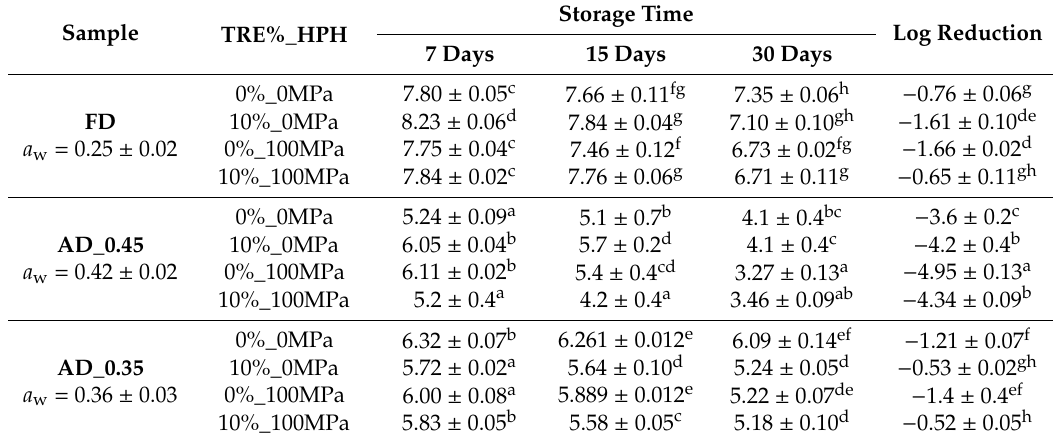
Table 3. Microbial counts in apple snacks during their storage for 30 days under controlled conditions. FD stands for freeze-dried apples, AD_0.45 stands for apples air-dried until reaching a a w ≈ 0.45 and AD_0.35 stands for apples air-dried until reaching a a w ≈ 0.35. Mean value of three replicates ± standard deviation. Di ff erent letters in the same column indicate statistically significant di ff erences with a